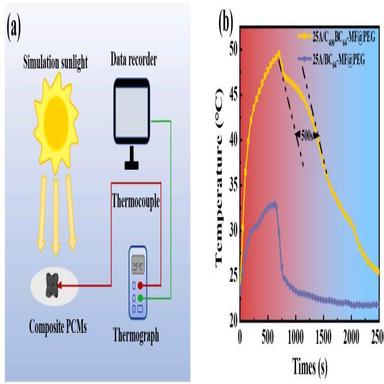
(a) Schematic diagram of the photo-thermal conversion experimental setup. (b) Photo-thermal energy conversion and storage curves of BC64-MF@PEG and C400BC64-MF@PEG.